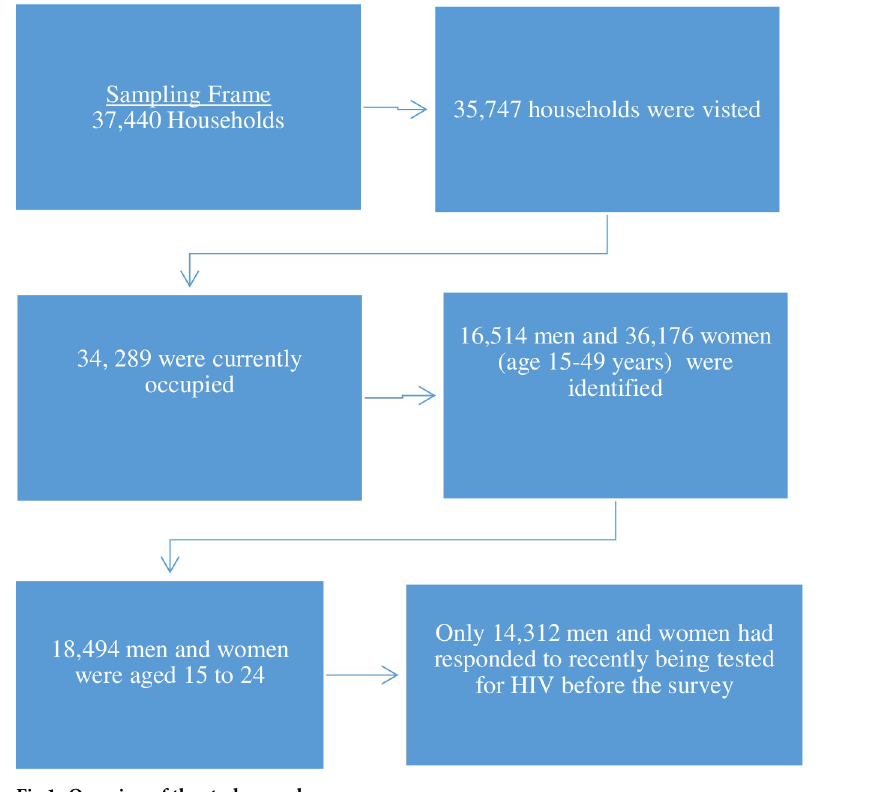
Fig 1. Overview of the study